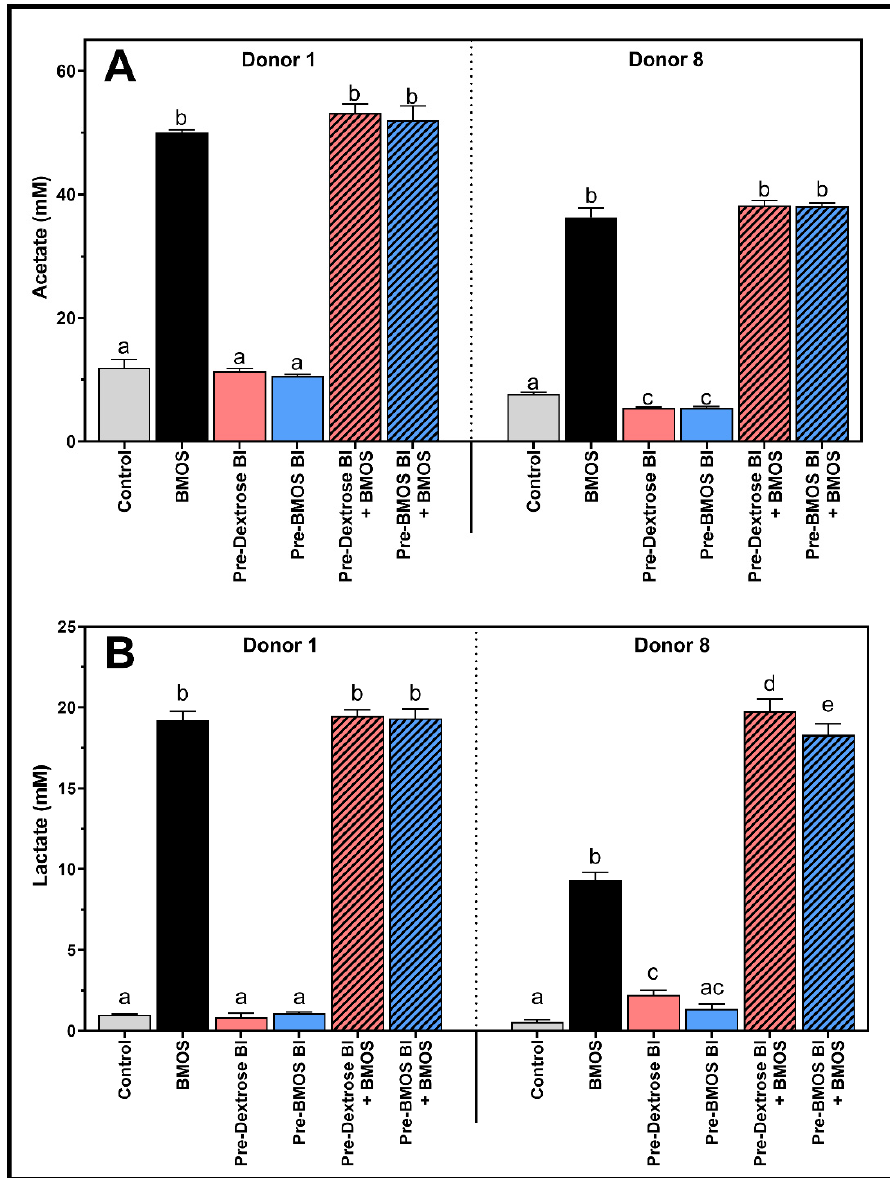
Figure 4. Mean ( ± standard deviation) microbial metabolic activity in terms of acetate production (mM) ( A ) and lactate production (mM) ( B ) upon a 48 h fermentation of 5 g / L BMOS containing 1.5 × 10 7 CFU / mL of B. lactis previously grown on either Dextrose (Pre-Dextrose Bl + BMOS, n = 3) or BMOS (Pre-BMOS Bl + BMOS, n = 3), by the infant fecal microbiota of Donors 1 and 8, versus their respective controls (Control, Pre-Dextrose Bl and Pre-BMOS Bl, n = 3). Significant di ff erences between the di ff erent formulations within each donor are indicated with di ff erent letters (a, b, c, d, e), as tested with a one-way ANOVA with Tukey’s HSD post hoc test ( p < 0.05). In contrast, when at least one letter is shared between two treatments, there was no significant di ff erence between these groups.